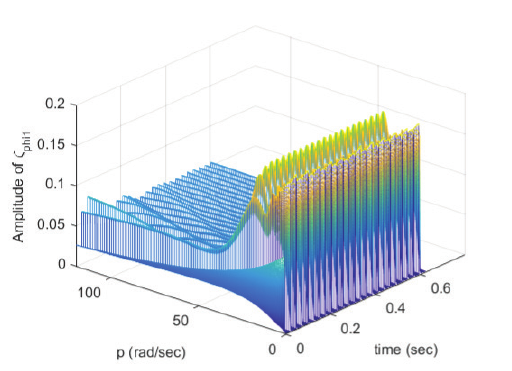
Figure 9. Roll rate e ff ect on time history of